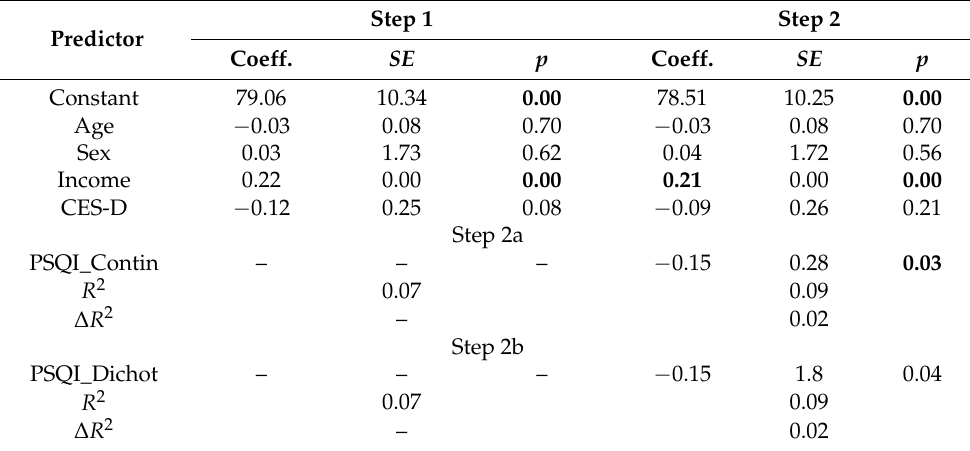
Table 5. Regression analyses of PSQI index of sleep in relation to social well-being; Step 2a uses PSQI continuous scale scores; CES-D = Center for Epidemiologic Studies Depression Scale (minus sleep item); Step 2b uses PSQI dichotomized (0 = good sleepers, 1 = poor sleepers); N = 213; standardized regression coefficients ( β ); bold font indicates